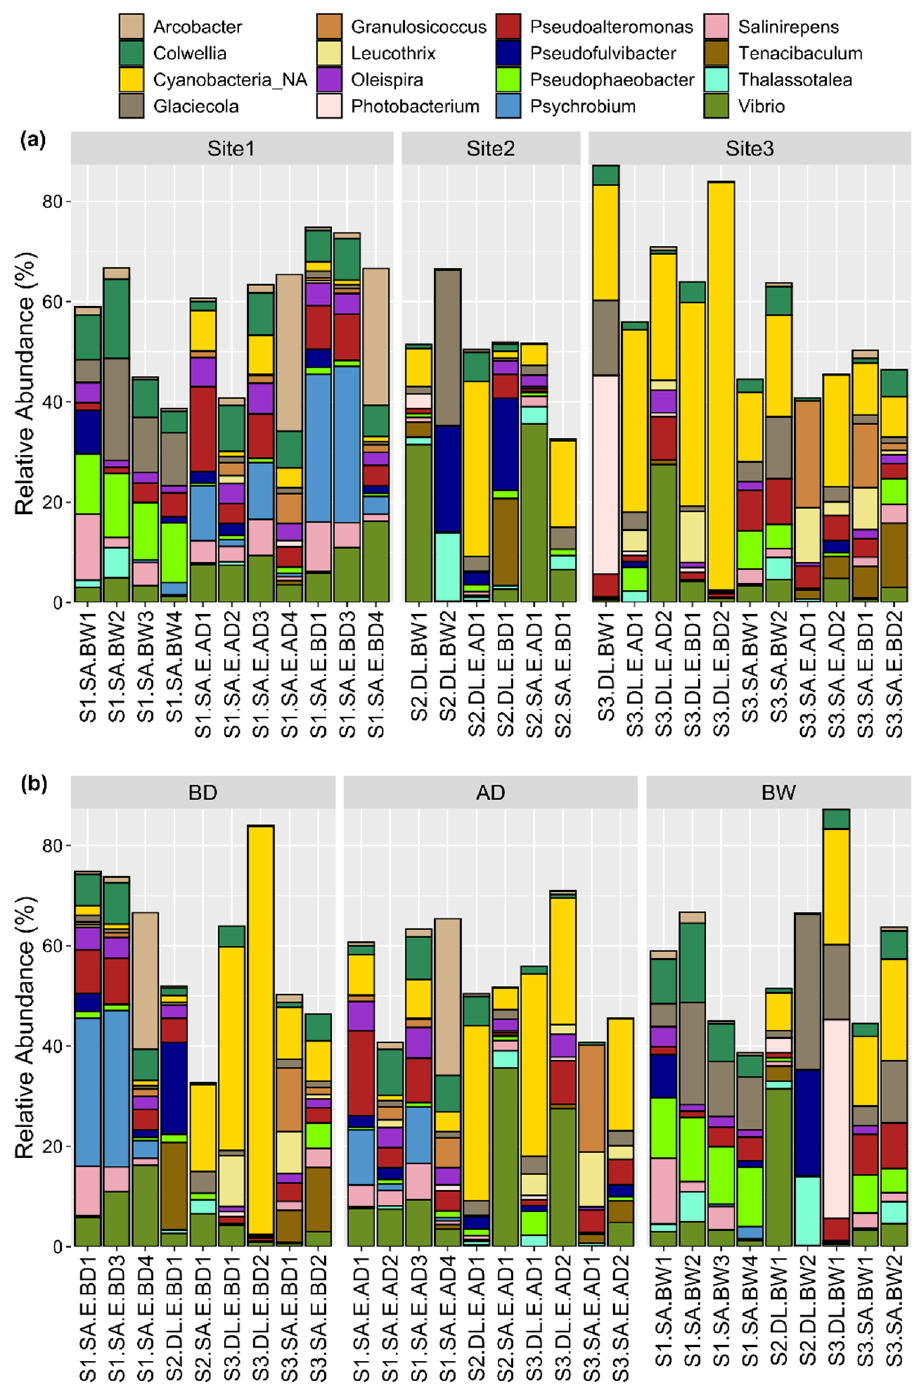
Figure 4. The relative percentage of the most abundant bacterial genera (top 15) across all egg and water samples. The bacterial genera present at the highest relative percentage, based on the sum of the percentage detected in all samples, were selected for presentation. The same data are rearranged and presented (using the ggplot2 R package) in relation to ( a ) the aquaculture site or ( b ) the type of sample including eggs (before disinfection, BD, and after disinfection, AD) and water samples (broodstock water,